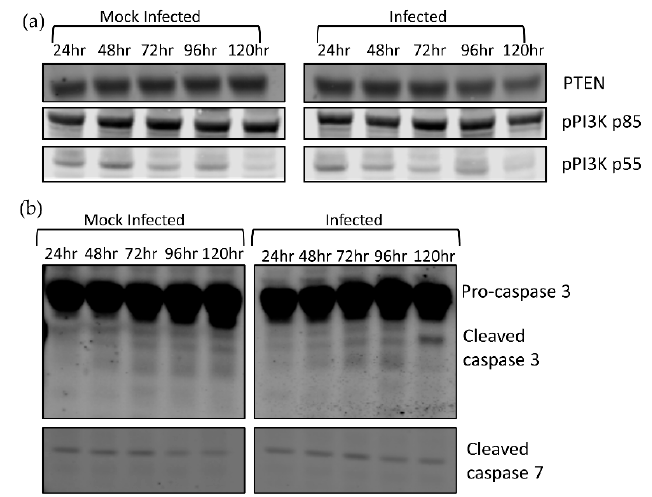
Figure 2. Analysis of factors responsible for AKT phosphorylation. 293T cells were infected with LGTV at an MOI of 0.1 and harvested at the indicated timepoints. ( a ) Western blot detecting PTEN, pPI3K, and pPI3Kp55 levels; ( b ) detection of cleaved caspase 3 cleavage at 120 h post-LGTV infection.